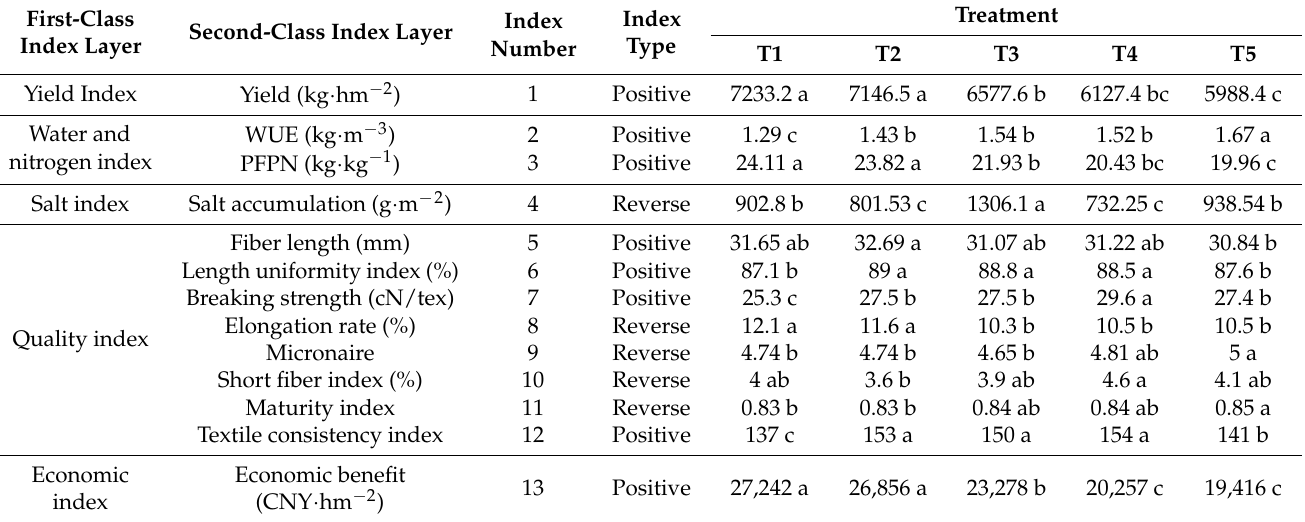
Table 4. Evaluation index layer and indices assignment.